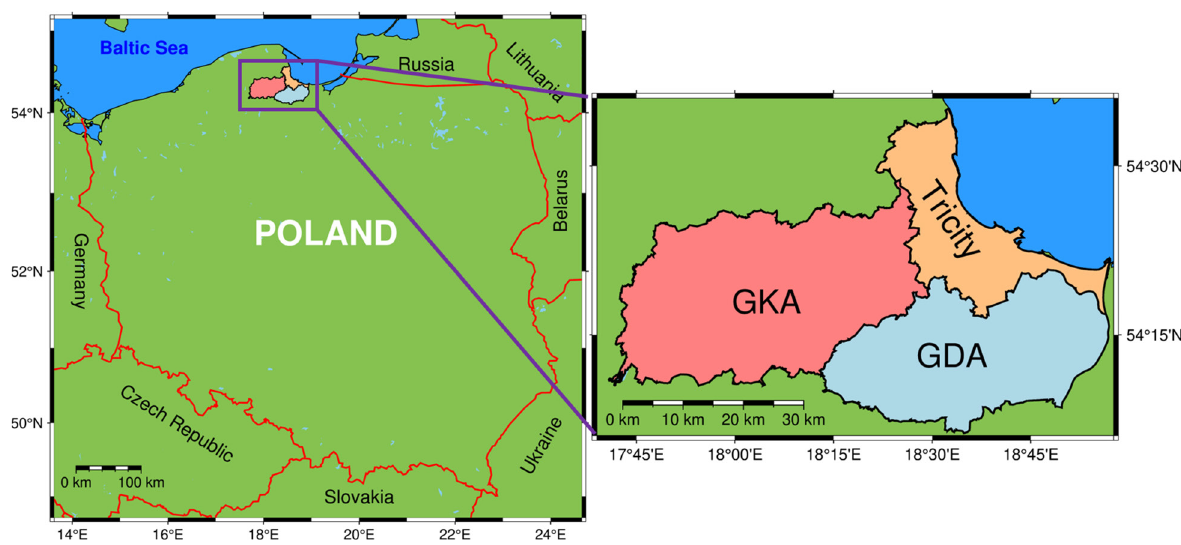
Fig. 1. Study area